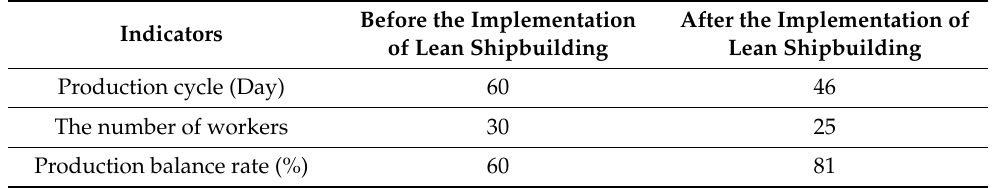
Table 3. The comparison of the shipyard’s production